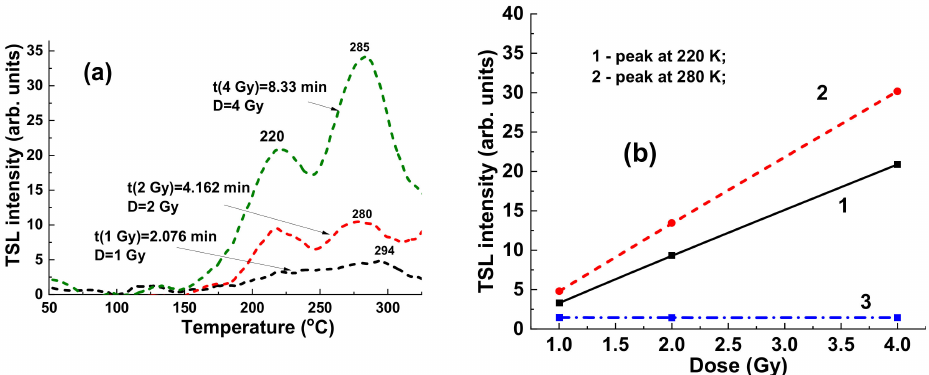
Figure 12. ( a ) Dependence of intensity of TSL glow curves for YAG:Ce crystal detector on the dose of irradiation by 60 Co source; ( b ) intensity of TSL glow peaks of YAG:Ce crystal at 220 ◦ C (1) and 285 ◦ C (2) source and I 285 /I 220 ratio of intensity of these peaks (3) on dose of γ rays irradiation by 60 Co.